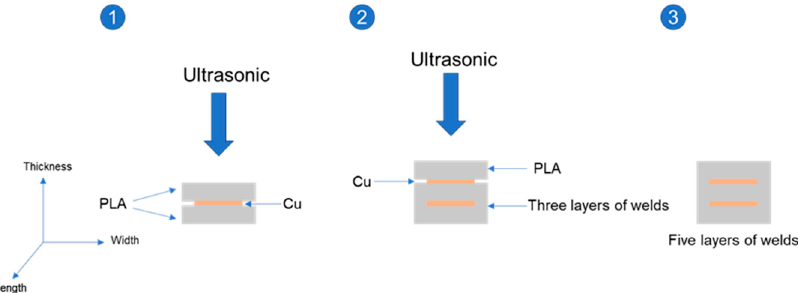
Figure 6. Schematic diagram of the forming process of metal embedded PLA weldment . Figure 5. Schematic diagram of the size of the round hole metal strip. Figure 5. Schematic diagram of the size of the round hole metal strip . Figure 5. Schematic diagram of the size of the round hole metal strip .